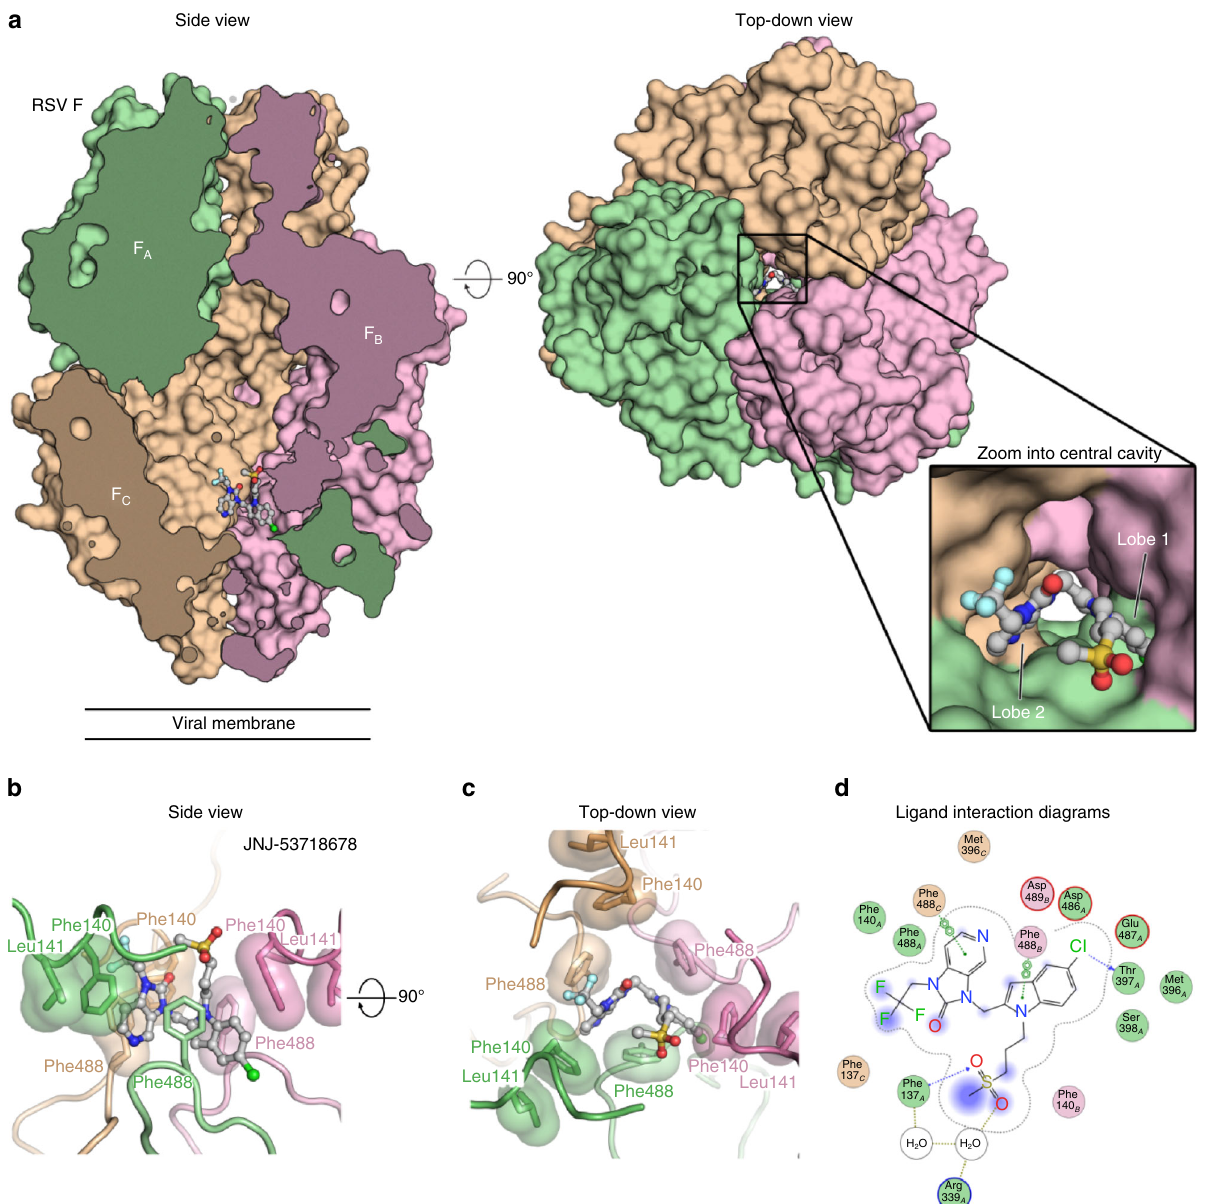
Fig. 1 JNJ-53718678 binds to a threefold-symmetric cavity in prefusion RSV F. a Side and top-down views of the crystal structure of JNJ-53718678 bound to prefusion RSV F. RSV F is shown as a molecular surface with the three identical protomers each shown in a different color (F A , green ; F B , pink ; and F C , tan ). JNJ-53718678 is shown as ball-and-stick representation with carbon atoms colored in grey , nitrogen atoms in blue , oxygen atoms in red , chlorine atom in dark green , fl uorine atoms in light blue , and sulfur atoms in orange . For clarity, part of the front hemisphere in the side view panel was removed. The inset provides a zoomed view of the binding of JNJ-53718678 into the central cavity. b , c Side b and top c views for JNJ-53718678 bound to prefusion RSV F. Each RSV F protomer is again shown in a different color corresponding to the colors in a , and hydrophobic side chains are shown with transparent molecular surfaces. JNJ-53718678 is shown as ball-and-stick representation with colors of atoms corresponding to the colors in a . d 2D ligand-interaction diagram generated in Molecular Operating Environment. Coloring of circles refers to the green (F A ), pink (F B ), and tan (F C ) protomers. Red and blue circled outlines represent negatively and positively charged groups, respectively. Bonds with RSV F main chain and side chain atoms are shown as blue and green dashed lines , respectively, and water-mediated interactions are shown as light brown dashed line s. When present, arrowheads point toward the